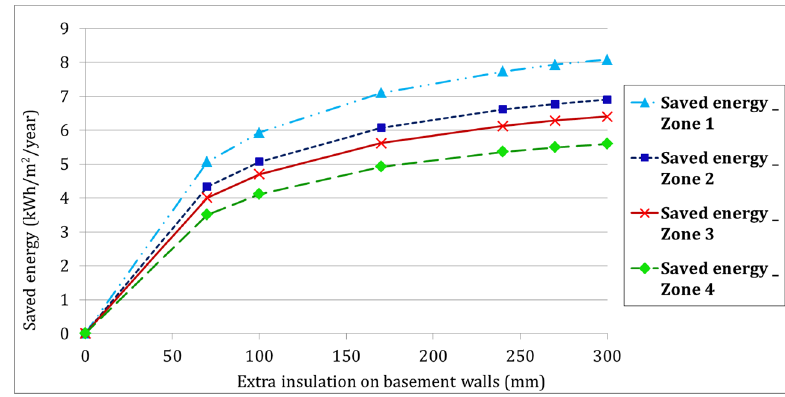
Figure 8. Saved energy for space heat demand due to additional insulation on the basement walls.